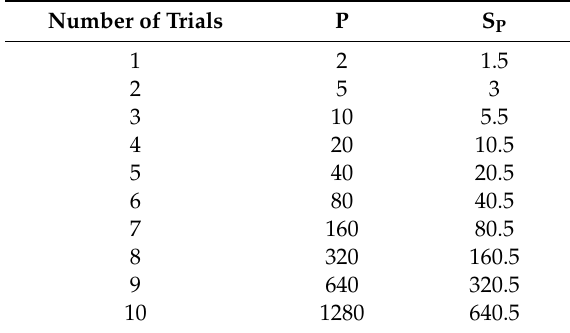
Table 5. The e ffi ciency of the parallel processing